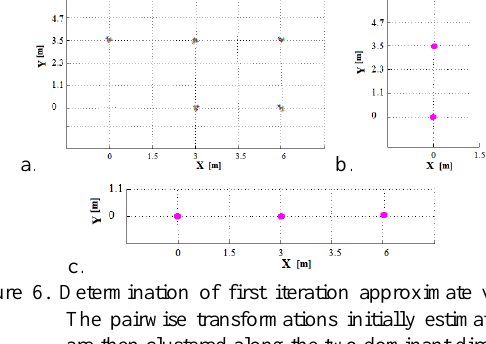
Figure 6. Determination of first iteration approximate values. The pairwise transformations initially estimated (a) are then clustered along the two dominant directions of the lattice (b-c) giving the initial estimates of the lattice structure.